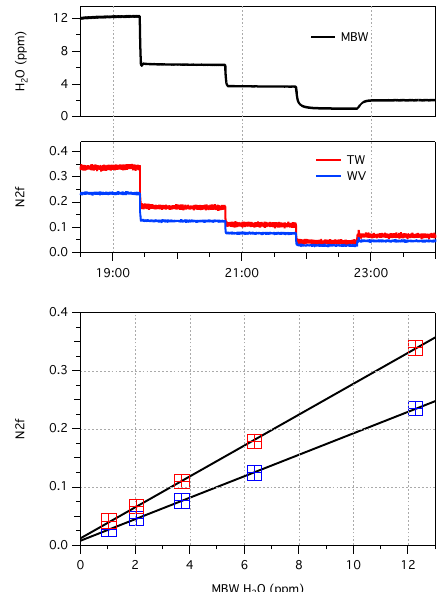
Figure 9. Laboratory calibration of the WV and TW channel strong absorption line signals at low H 2 O mixing ratios. Top: time series of water vapor values in the sample flow as measured by the MBW ref- erence hygrometer. Middle: corresponding time series of the strong absorption line laser power normalized second harmonic (N2f) sig- nals in each channel. Bottom: linearity of the N2f signals at low mixing ratios. Repeated long-duration calibrations at low mixing ra- tios were used to quantify and verify the stability of the background water signal from residual water in the laser and detector